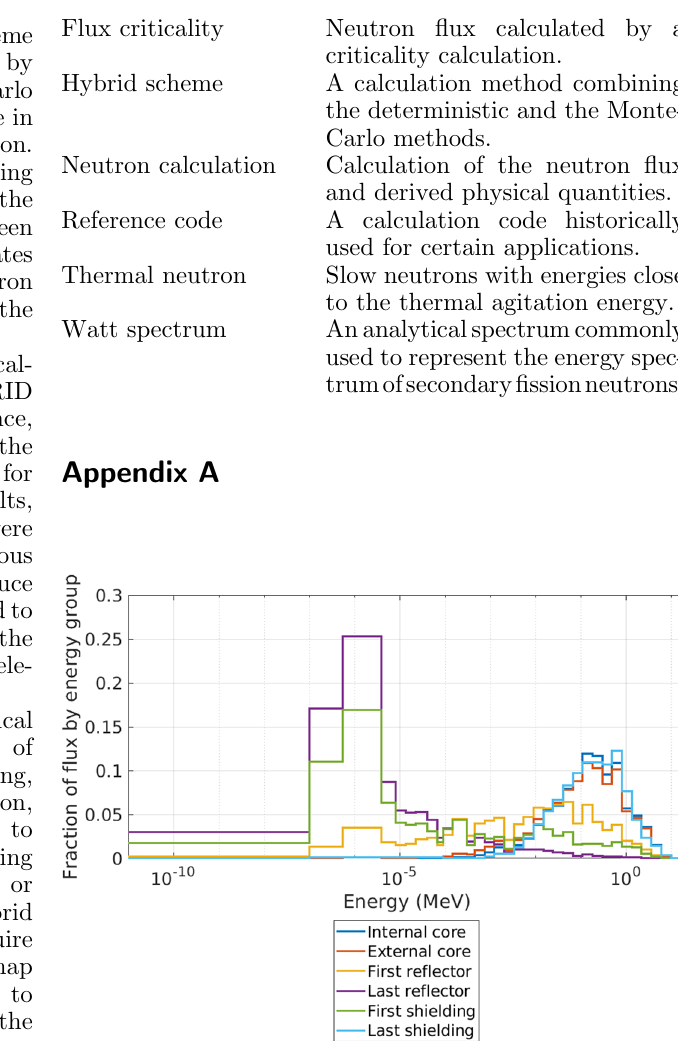
Fig. A1. Evolution of the neutron fl ux in the core, the re fl ector and the shielding of ASTRID (TRIPOLI-4 ® calculations).